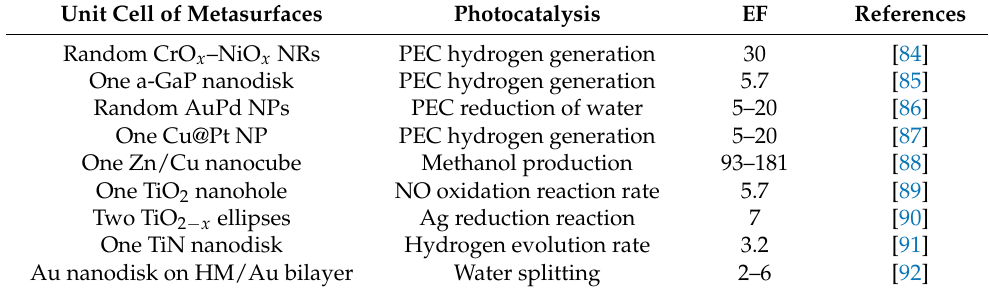
Unit cell of metasurfaces, reactions of photocatalysis and their EF (CrO x = p - type Chromium Oxide; NiO x = p -type Nickel Oxide; NRs = Nanorods; PEC = Photoelectro- chemical; a-GaP = amorphous Gallium Phosphide; AuPd = Gold/Palladium; NPs = Nanopar- ticles; Cu@Pt = Copper–Platinum Core–Shell; Zn/Cu = Zinc/Copper; TiO 2 = Titanium Diox- ide; NO = Nitrogen Monoxide; TiO 2 − x = Loss-engineered Substoichiometric Titanium